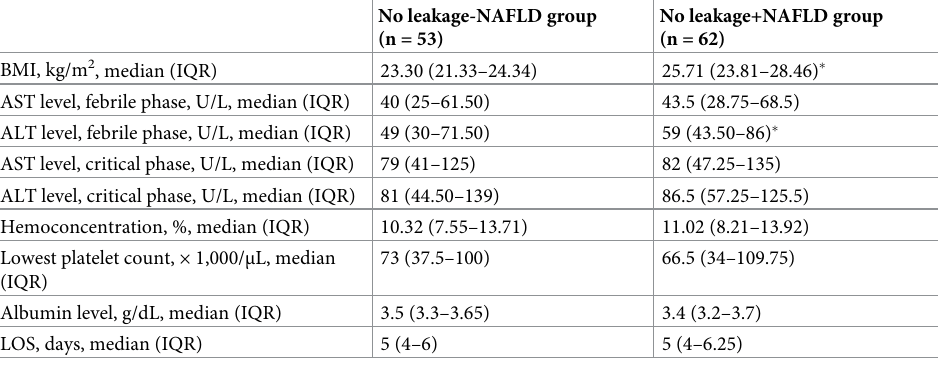
Abbreviations: NAFLD, nonalcoholic fatty liver disease; BMI, body mass index; AST, aspartate aminotransferase; ALT, alanine aminotransferase; IQR, interquartile range; LOS, length of hospital stay